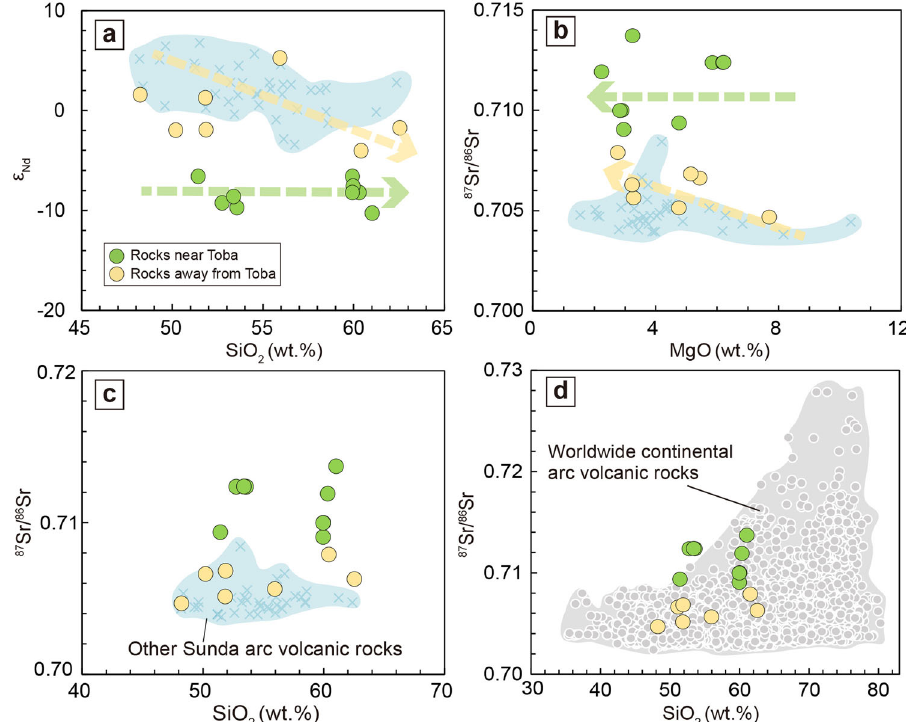
Fig. 3 Compositions of the studied volcanic rocks in northern Sumatra. a ε Nd versus SiO 2 diagram displaying a roughly negative correlation for rocks away from Toba in this study and in literatures (other Sunda arc volcanic rocks 17,39,40 ), whereas the ε Nd ratios of rocks near Toba do not vary with increasing SiO 2 contents. b 87 Sr/ 86 Sr versus MgO diagram displaying a roughly negative correlation for rocks away from Toba, whereas that of rocks near Toba does not exhibit an obvious correlation. c 87 Sr/ 86 Sr versus SiO 2 diagram showing that the rocks near Toba have higher 87 Sr/ 86 Sr ratios than those away from Toba, which have similar 87 Sr/ 86 Sr values with other Sunda arc volcanic rocks 17,39,40 . d 87 Sr/ 86 Sr versus SiO 2 diagram showing that the basalts near Toba have the highest 87 Sr/ 86 Sr ratios among worldwide continental arc basalts. Compositions of worldwide continental arc volcanic rocks are from the GEOROC database (http://georoc.mpch-mainz.gwdg.de/georoc/Start.asp).